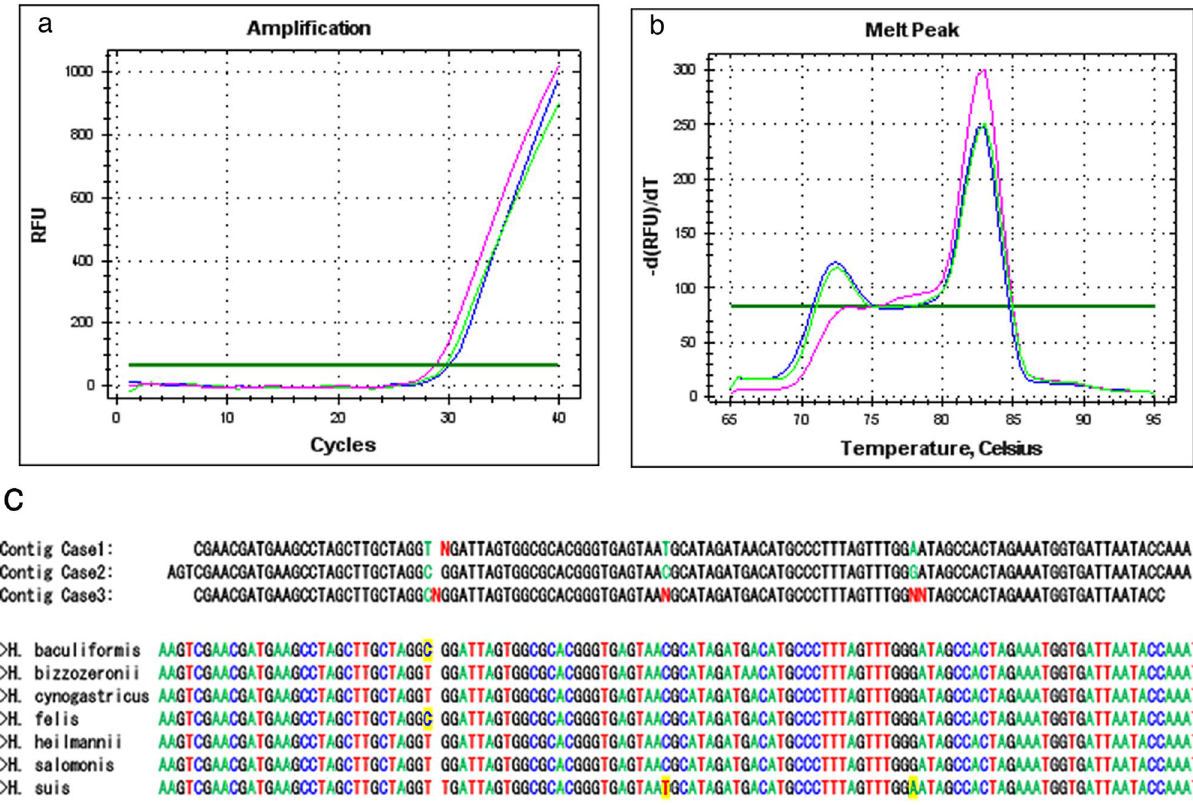
Figure 1. NHPH PCR. ( a ) NHPH PCR amplification curves for the three positive patients are shown. The amplification curves rise around 26 cycles. Three independent experiments showed the similar results. ( b ) Melting curves of these three PCR products are shown, demonstrating specific products. ( c ) Sequence results of PCR products from the three patients aligned with various NHPH strains colonized in